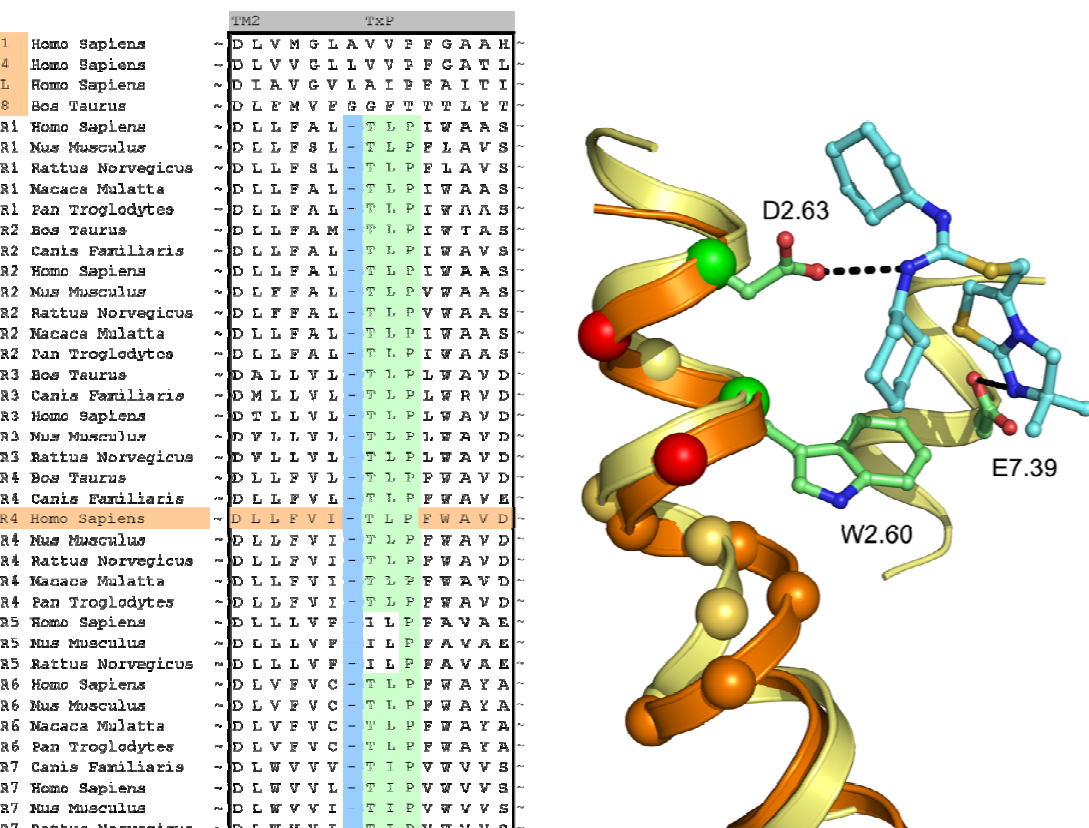
Figure 4. Sequence conservation of the TxP motif in the CXCR family and the implication of a possible misalignment on the amino acids pointing into the TM bundle. Using the unadjusted TM2 template of ADRB2 (orange ribbon and C spheres) would place alpha spheres, where the residues would not contact the W2.60 and D2.63 on the red C alpha ligand. In the CXCR4 crystal structure (yellow ribbon and C spheres), W2.60 and D2.63 alpha are positioned on the green C spheres, indicating a shift from the ADRB2 alpha